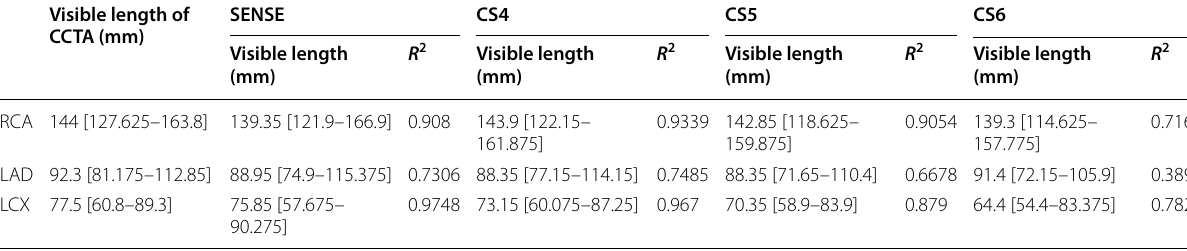
Metric data are reported as median and interquartile range RCA right coronary artery; LAD left anterior descending artery; LCX left circumflex artery